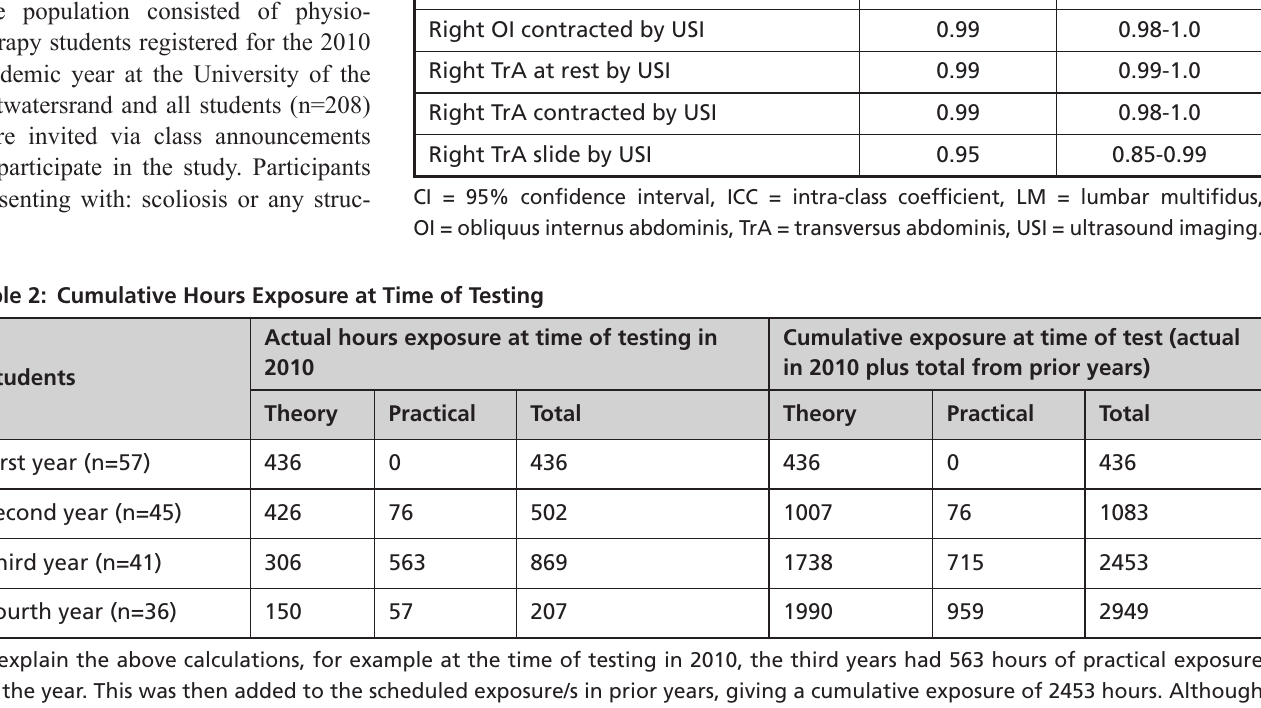
Table 1: Repeatability of the Physical Tests (n=13)